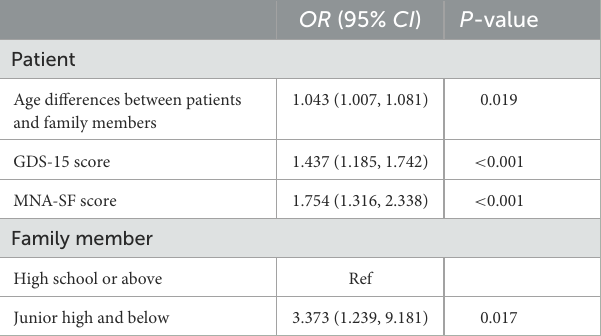
TABLE 4 The patient and family member factors associated with discordance attitudes toward ACP by multivariate logistic